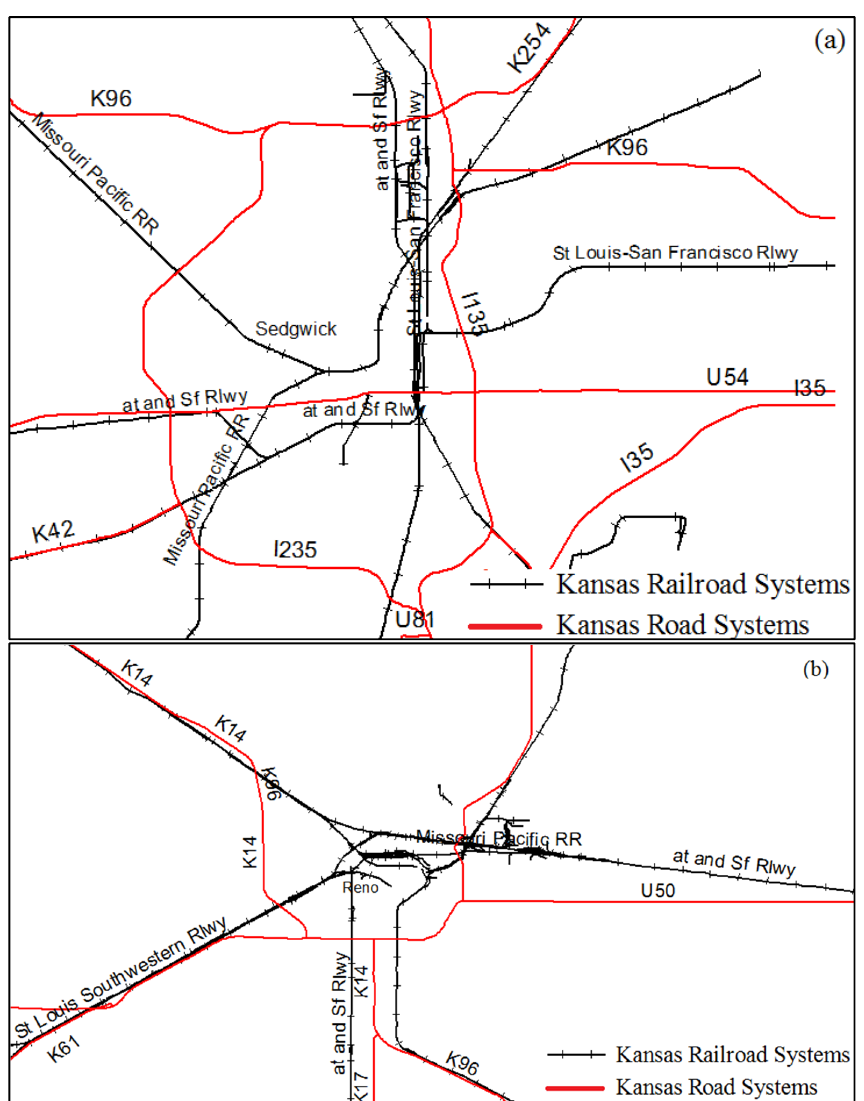
Figure 4. Highway (red) and rail systems (black) of ( a ) Sedgewick County and ( b ) Reno